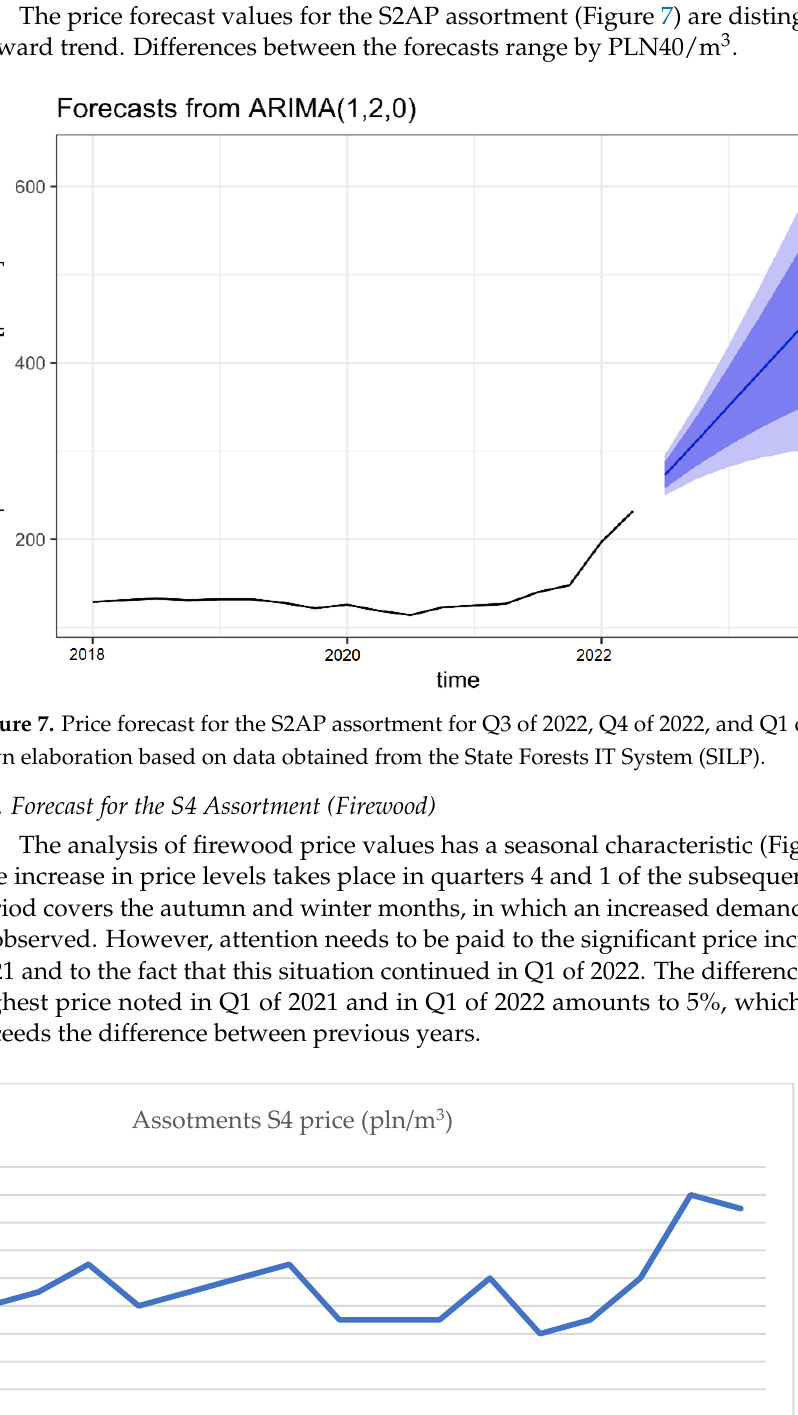
Figure 9. Price forecast for the S4 assortment in Q3 of 2022, Q4 of 2022, and Q1 of 2023. Source: Own elaboration based on data obtained from the State Forests IT System (SILP) [4]. Table 4. Price forecast for the S4 assortment in Q3 of 2022, Q4 of 2022, and Q1 of 2023. Source: Own elaboration based on data obtained from the State Forests IT System (SILP). Time Point Forecast (pln/m 3 )